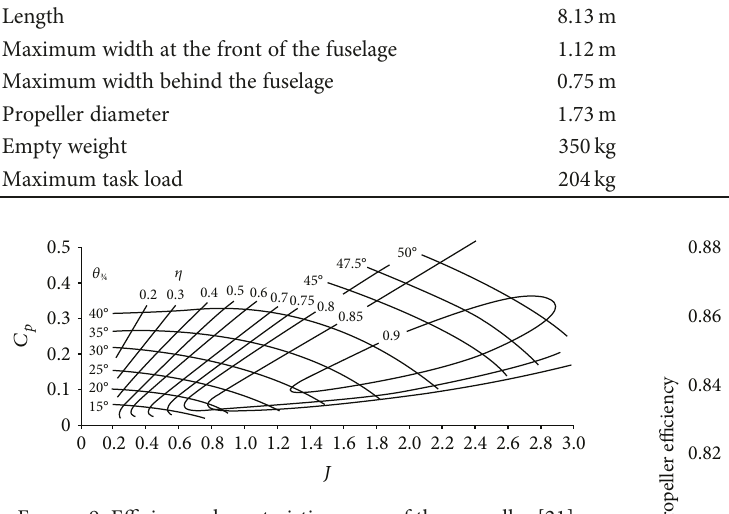
Figure 9: E ffi ciency characteristic curves of the propeller [21].